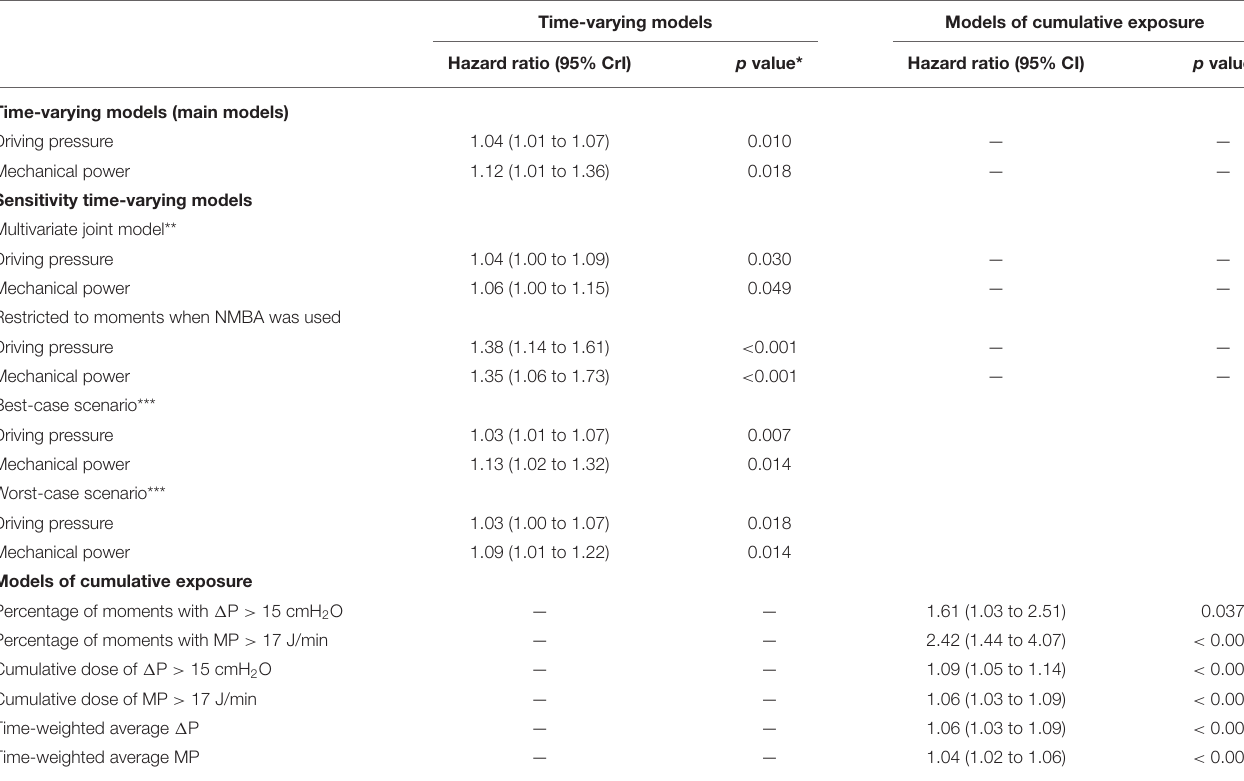
TABLE 2 | Multivariable model assessing the association of time-varying driving pressure and mechanical power over the first four days of ventilation with 28-day